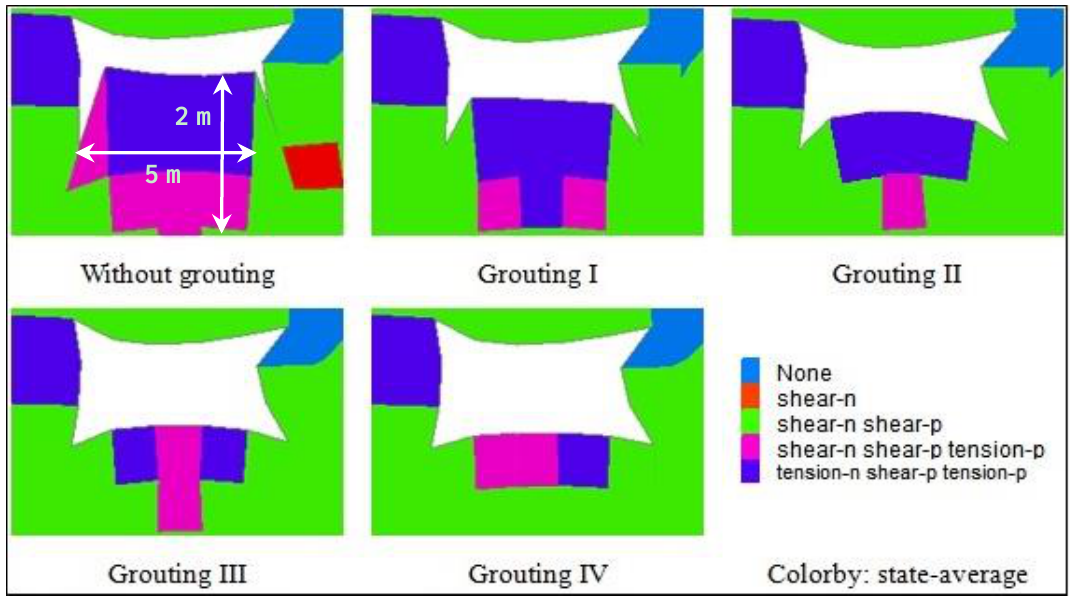
Figure 13. Plastic zone distribution in floor strata reinforced by different grouting schemes.